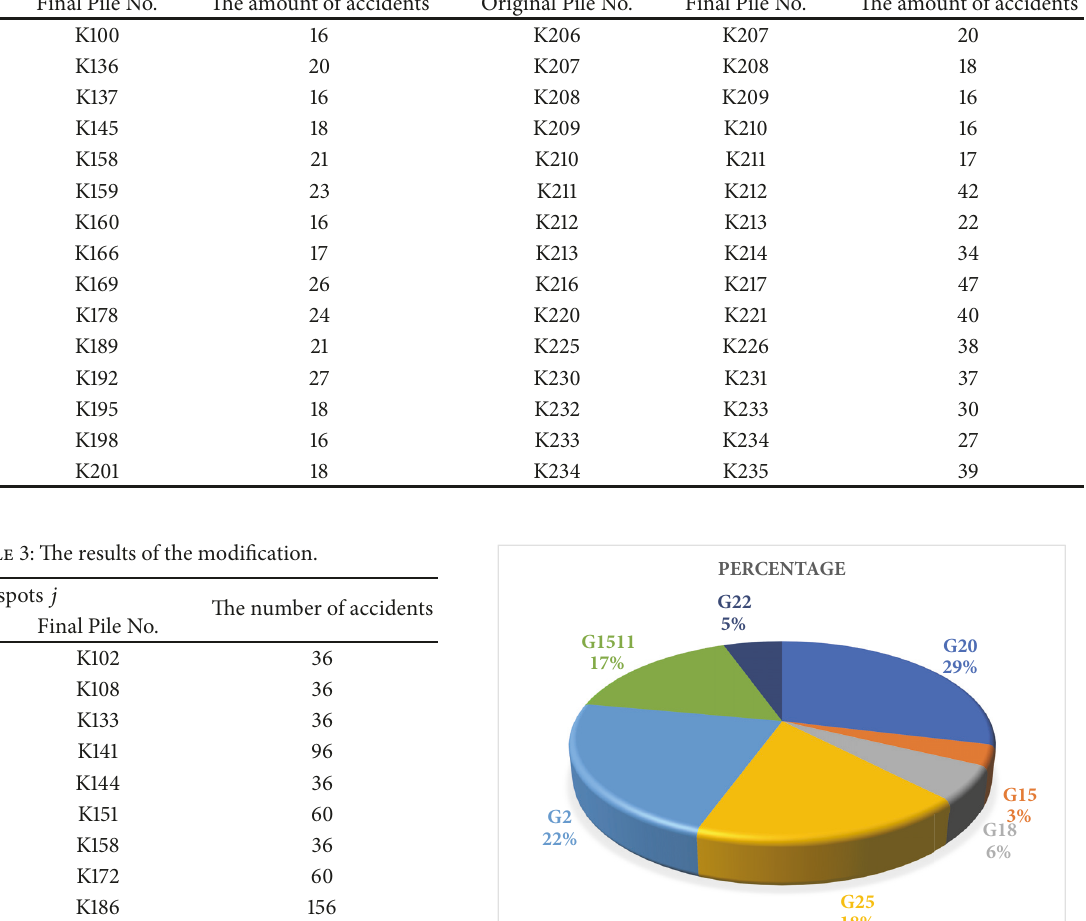
Original Pile No.